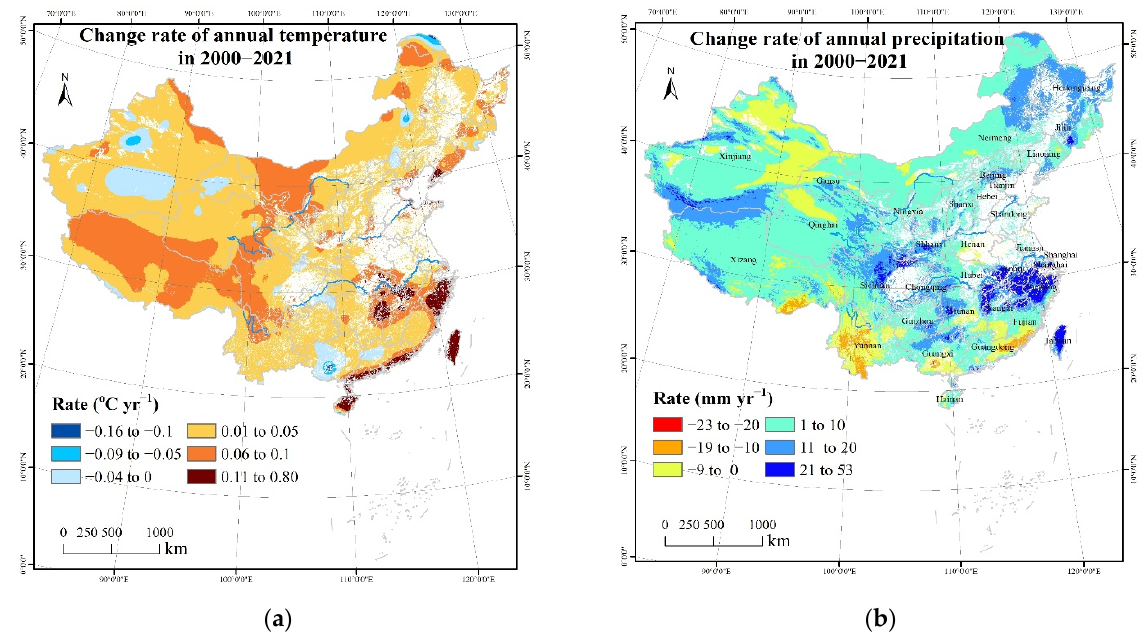
Figure 3. Warm − wet climate trend judging by the change rate of annual air temperature ( a ) and annual precipitation ( b ) for each 1 km × 1 km grid cell in the main ecosystems except for crop land (white color is crop land) over China in 2000 − 2021. Positive values denote an increasing trend; negative values denote a decreasing trend.